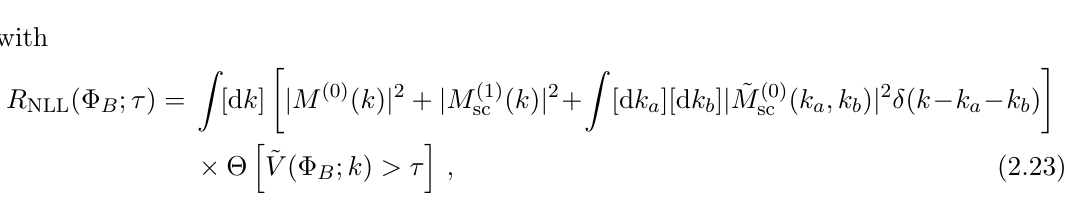
Table 1 . The order at which the various n PC ( j ) are required for the computation of (cid:6) max ( v ) and F ( v